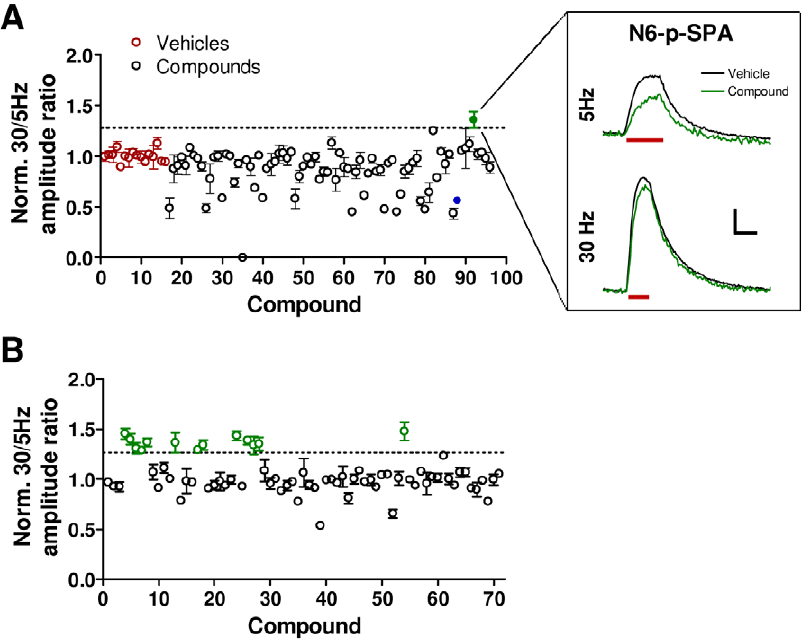
Figure 6. High frequency stimulation overcomes adenosine A1 agonist-induced suppression of synaptic vesicle release. ( A ) The ratio of the amplitudes of the responses to the 30 Hz train to amplitudes of the responses to the 5 Hz train was determined for the compounds from the LOPAC plate described in Figure 5C. The depicted data (mean 6 SEM) were normalized to the mean of the vehicle control wells. Dashed line indicates three standard deviations from the mean of the vehicles. Red points indicate vehicle wells. Blue point indicates PMA. Green point indicates N6- phenyladenosine. Inset shows the average waveforms from the three replicates of N6-phenyladenosine and the 36 vehicle replicates from the three replicate screening plates. Red bars indicate periods of stimulation Scale bar: 0.05 D F/F, 20 sec. ( B ) A single plate of compounds targeting adenosine and purine receptors (Enzo Life Sciences) was screened as described in Figure 5C. Data are as described in (A). Green circles indicate compounds that generated effects greater than three standard deviations from the mean of the